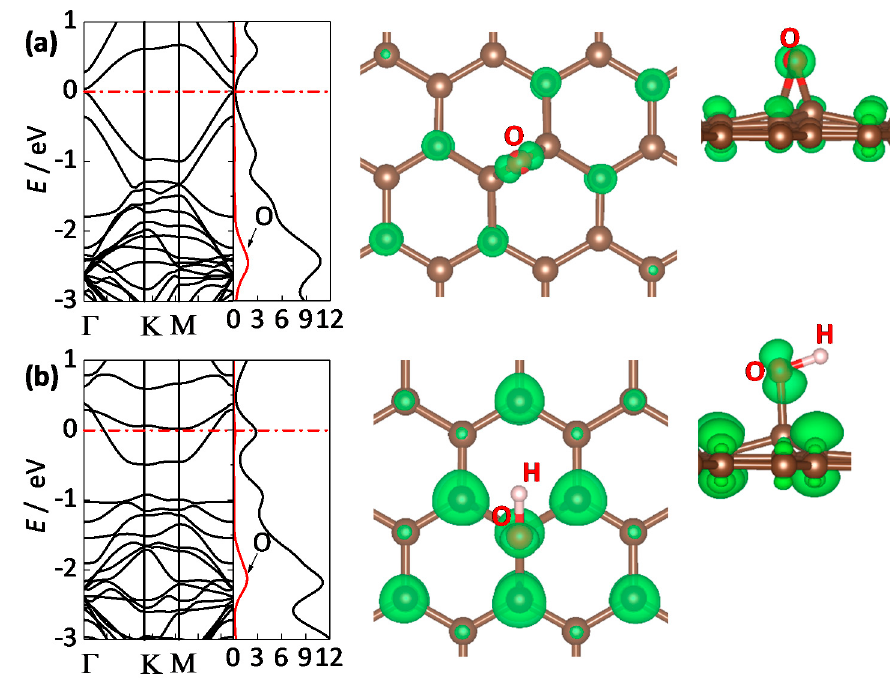
Figure 9. Band structure, density of states (DOS) and band-decomposed charge density (BDCD) iso-surfaces (0.006e/Bohr 3 ) of ( a ) graphene with –COC–; ( b ) graphene with –OH.